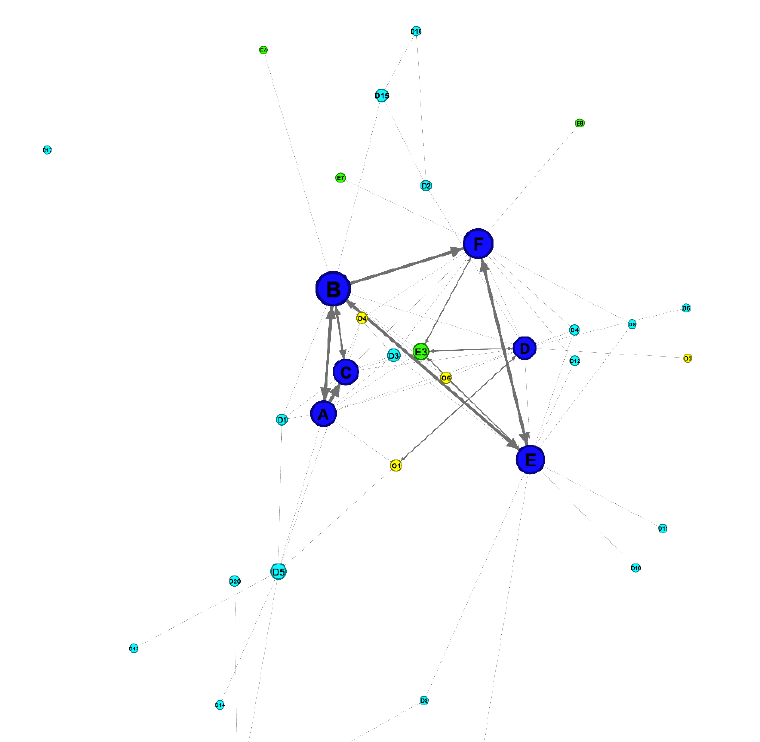
Figure 3. Selection of nodes. Notes: Projects (blue nodes), departments (bright blue nodes), internal learning platforms (yellow nodes), and external learning platforms (green